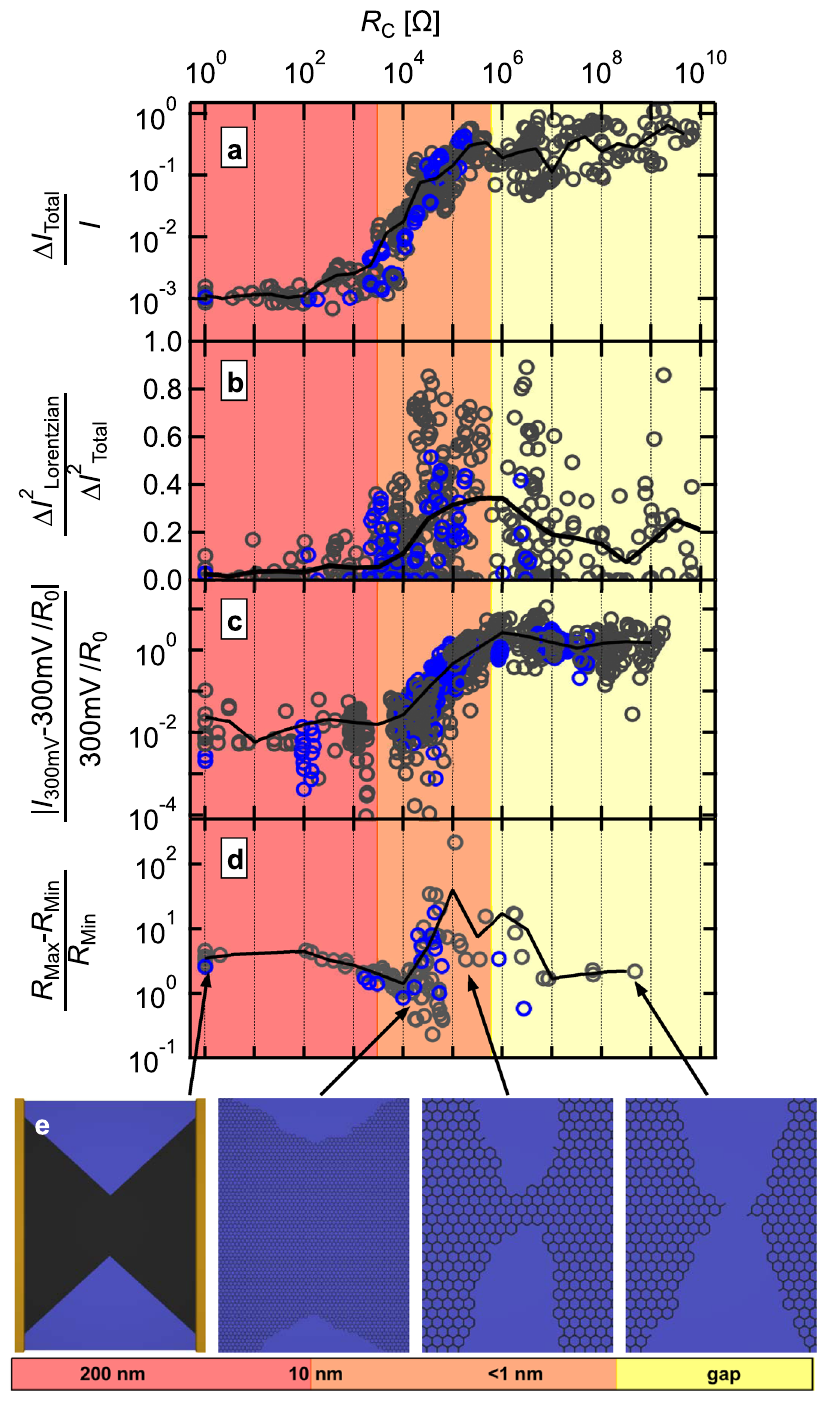
Fig. 3 Resistance dependence of the noise, I ( V ) nonlinearity, and gate response characteristics for a statistical ensemble of junctions. The relative current fl uctuation ( a ), the relative Lorentzian noise contribution ( b ), the I ( V ) nonlinearity ( c ) and the relative gate response amplitude ( d ) as a function of the constriction resistance ( R C ) along several steps of the EB process. a , b [( c , d )] display data acquired on 10 [6] different devices. The gray (blue) dots correspond to graphene samples patterned on Si/SiO 2 (Si/Si 3 N 4 ) substrates, respectively. The black lines is a – d represent averaged characteristics. The bottom cartoons ( e ) illustrate the characteristic width of the graphene constriction at the different stages of the breakdown process (see